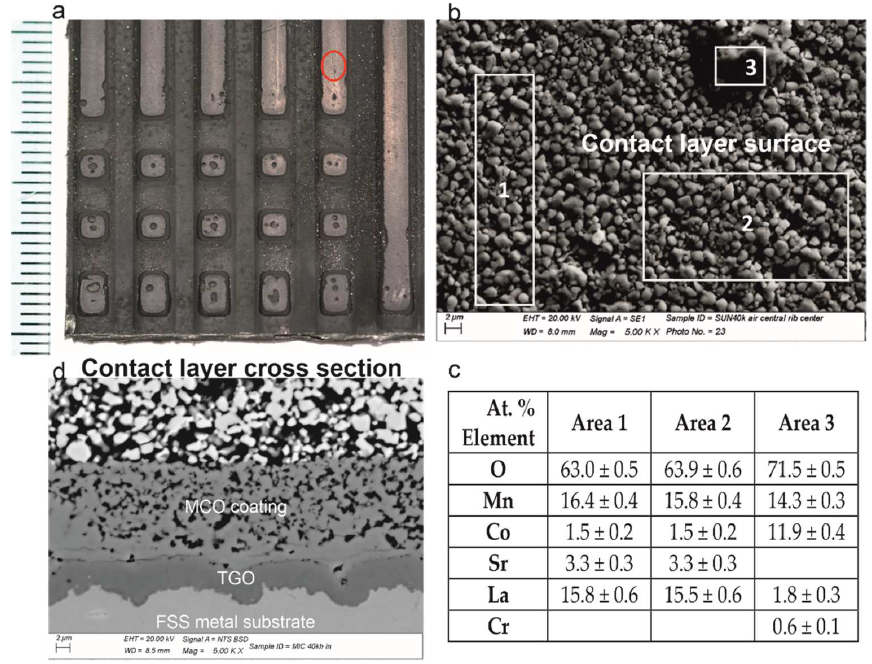
Figure 2. From top-left clockwise: ( a ) the interconnect aspect at the inlet with defects on the rib’s surface; ( b ) SEM-BSE details of the contact layer surface on top of the rib; ( c ) EDXS analyses of the top of the rib; ( d ) cross-sectional features representative of the three layers (i.e., from top to bottom: contact layer, MCO and TGO).